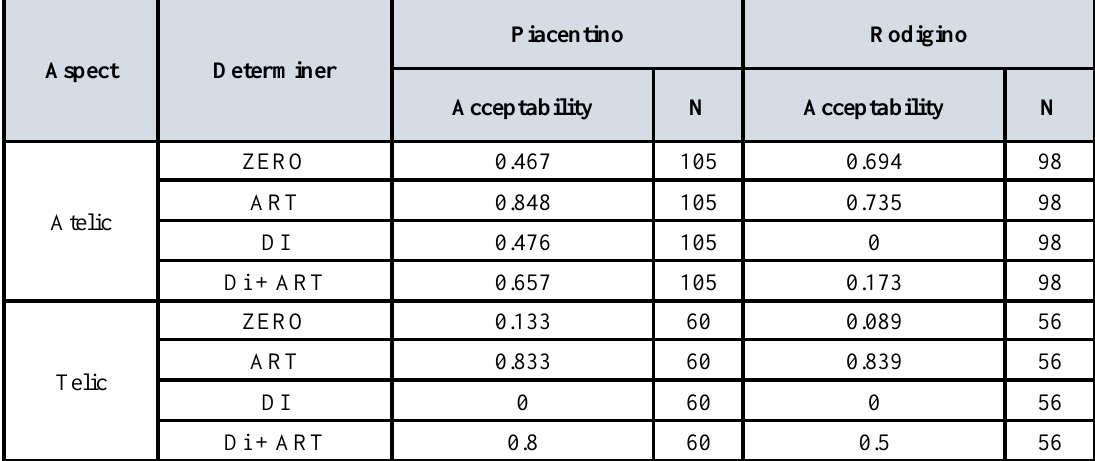
Table 4. Proportion of acceptable realizations (“Acceptability”) and number of collected judgements (“N”) as a function of aspectual class, determiner type and dialect.